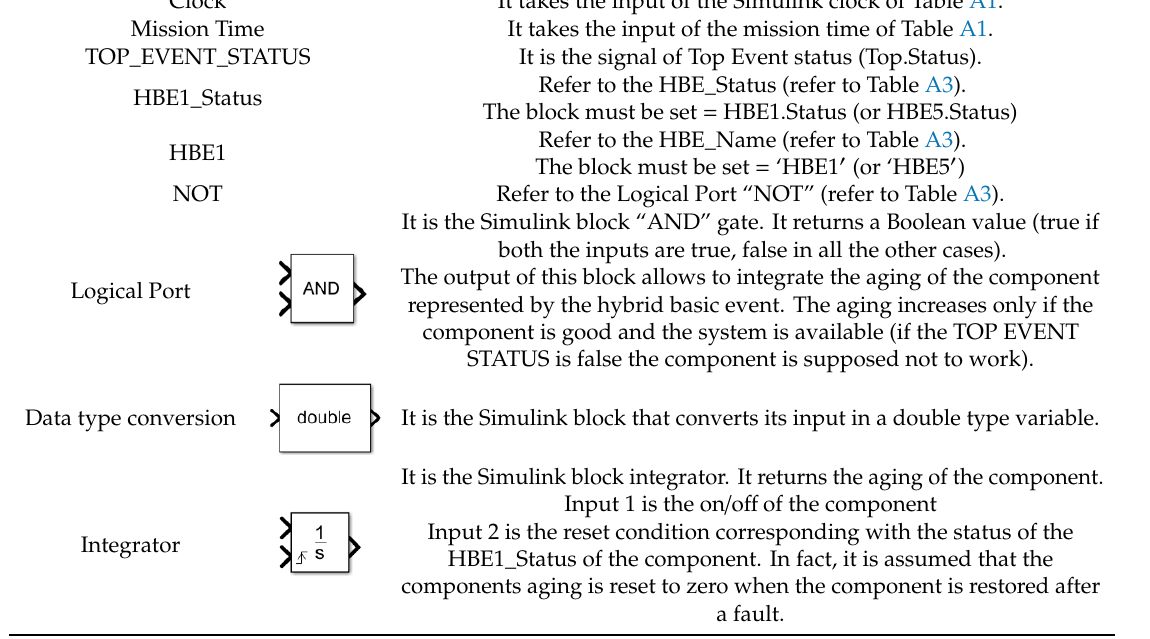
Table A8. Marking of the components of the hybrid basic events HBE2 (referring to Figure